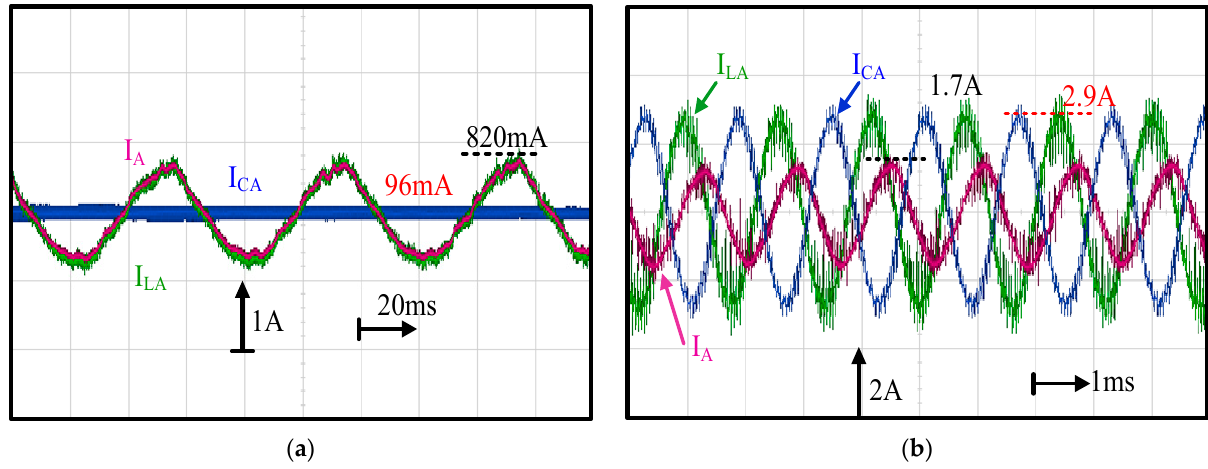
Figure 10. Experimental comparison of A-phase inverter output current I LA , capacitor current I CA and machine actual current I A at ( a ) a low speed of 1 krpm and ( b ) a high speed of 40 krpm (FOC drive and fan load).